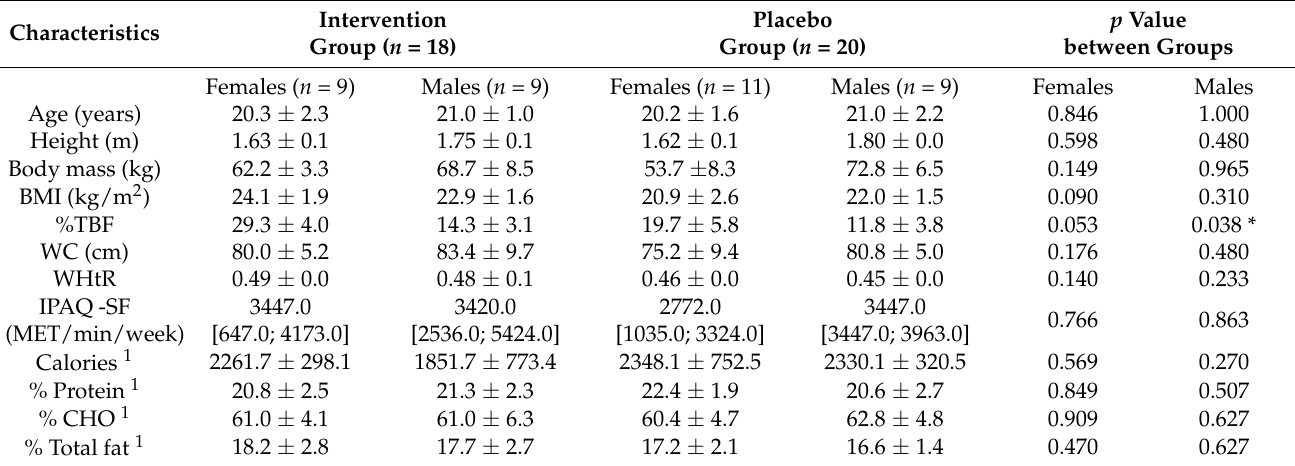
Table 2. Baseline characteristics of participants according to sex.